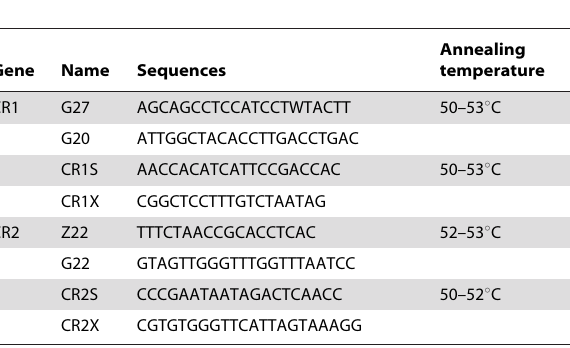
Table 2. Specific primers used to amplify duplicate CRs in Platysternon megacephalum .